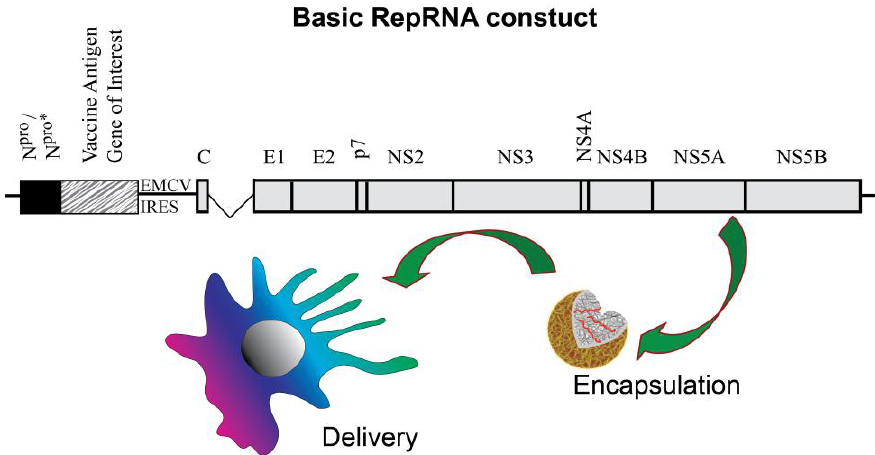
Figure 2. The basic RepRNA construct ensures efficient translation of the encoded vaccine antigen of interest, as well as replication of the replicon. Insertion of an internal ribosomal entry site (IRES) from, for example, EMC virus ensures that translation of the proteins for replication continues after translation of the vaccine antigen of